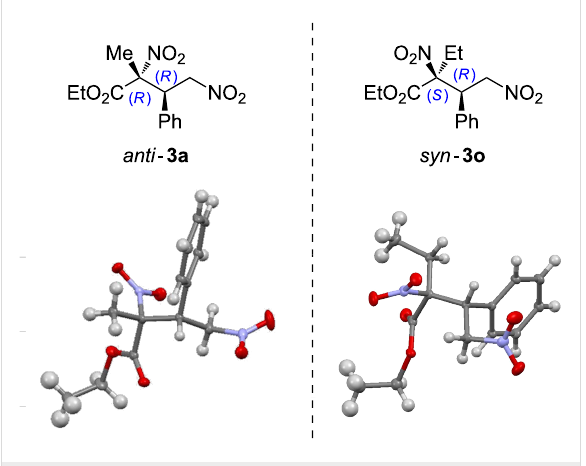
Figure 1: ORTEP diagrams for anti - 3a and syn - 3o